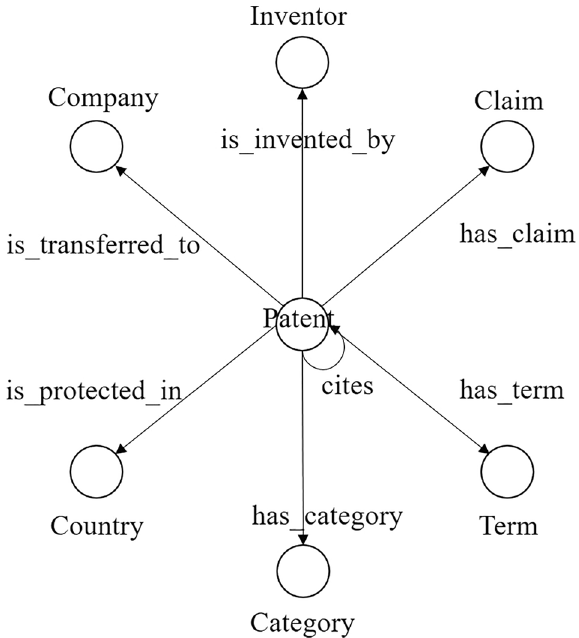
Figure 2. The graph schema of the knowledge graph.